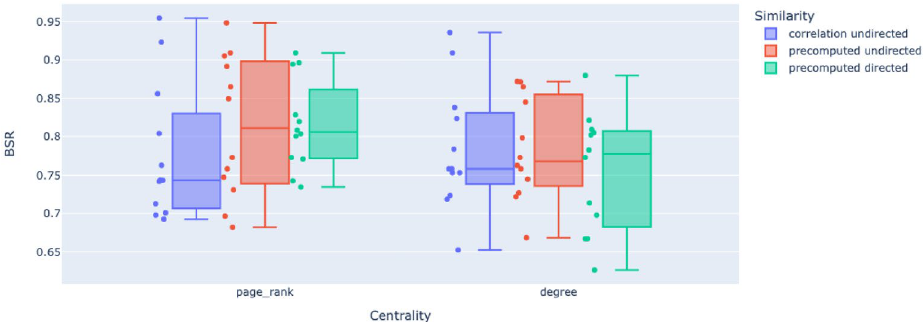
Figure 1. The distribution of BSR across experiments for each CPE configuration. Notice pre-computed, directed edges with PageRank centrality has the one of the highest BSRs while maintaining the lowest variance. All experiments apply LIMMA using subject identifier to the